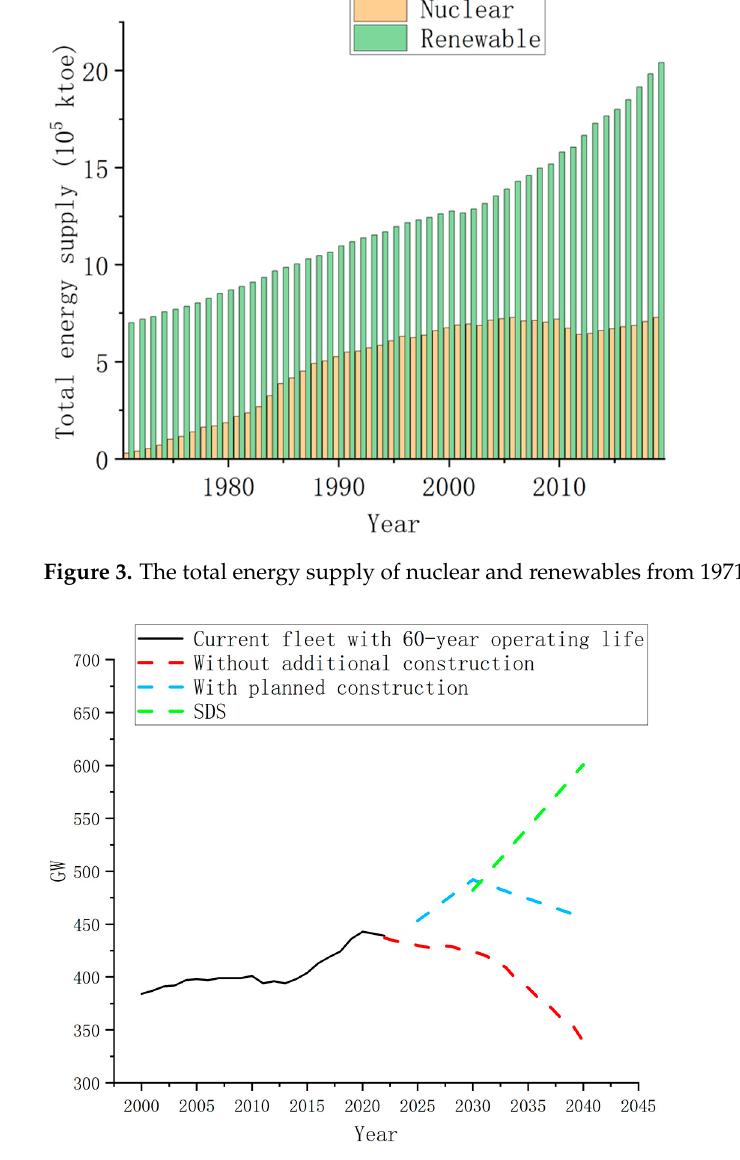
Figure 4. The development of nuclear energy under differing conditions.